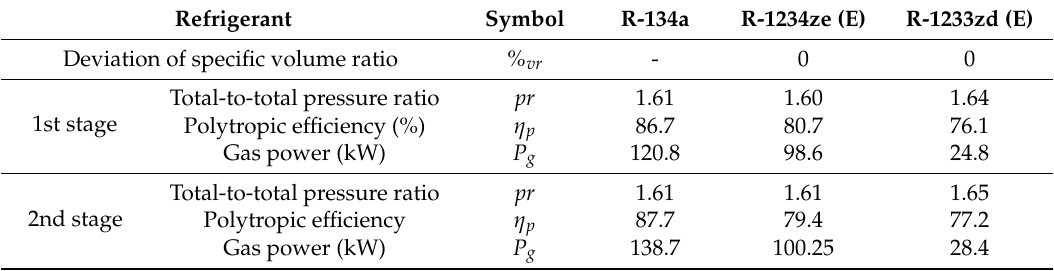
Table 5. Performance prediction results of alternative refrigerants at predicted operating